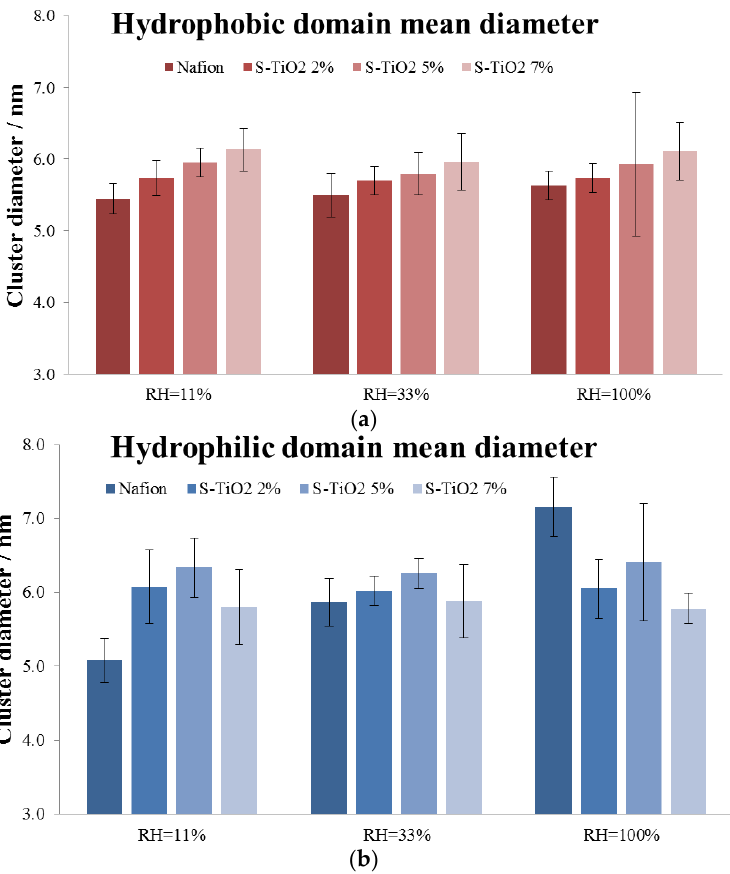
Figure 4. AFM image analysis: ( a ) trends of the hydrophobic; and ( b ) hydrophilic cluster dimensions. Two general trends are